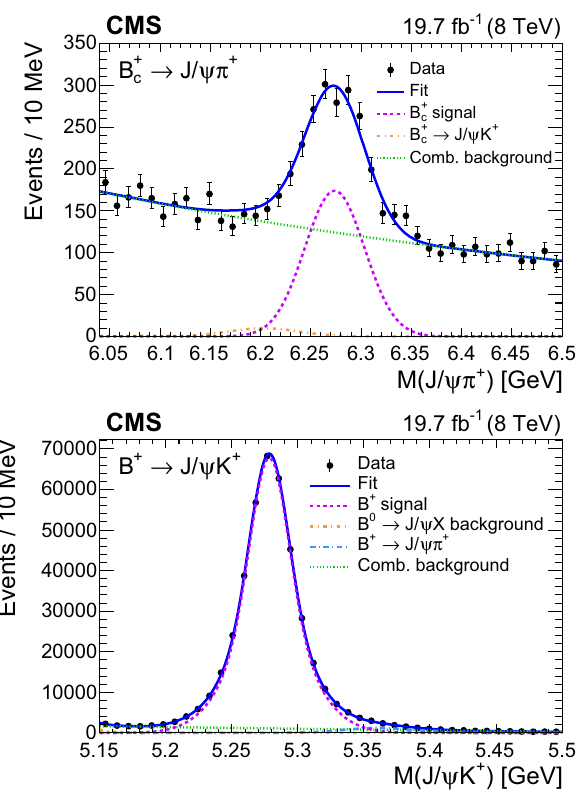
Fig. 6 Yields of B + c → J /ψπ + and B + → J /ψ K + events (left) as a function of ct , normalized to the bin width, as determined from fits to theinvariantmassdistributions.RatiooftheB + c andB + efficiencydistri- butions (right) as a function of ct , as determined from simulated events. Theverticalbarsonthedatapointsrepresentthestatisticaluncertainties, and the horizontal bars show the bin widths